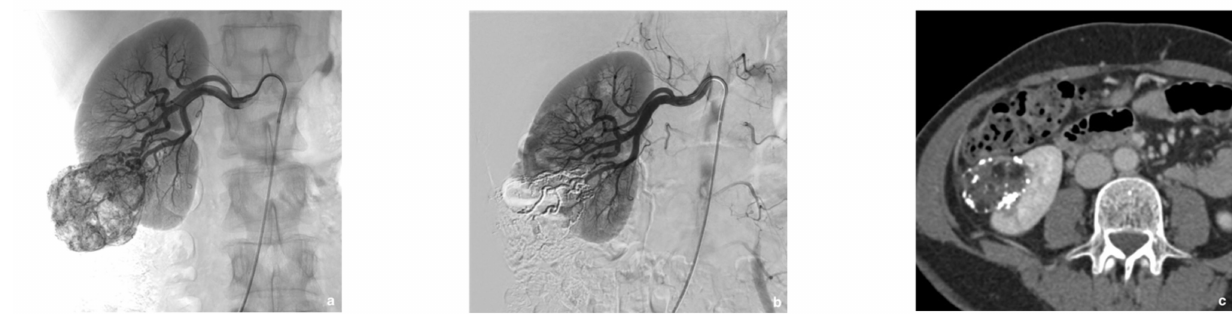
Figure 1. Prophylactic selective arterial embolization of a large right renal angiomyolipoma (rAML). ( a ) Angiogragram demonstrates two feeding arteries to the hypervascular angiomyolipoma. ( b ) Final angiographic control after superselective embolization of the two arterial branches with a Glubran ® 2/Lipiodol ® mixture in a 1:6 ratio. ( c ) Computed tomography scan at the portal phase 2 weeks later showing lipiodol distribution within the rAML and confirming targeted embolization with no more enhancement of the rAML.